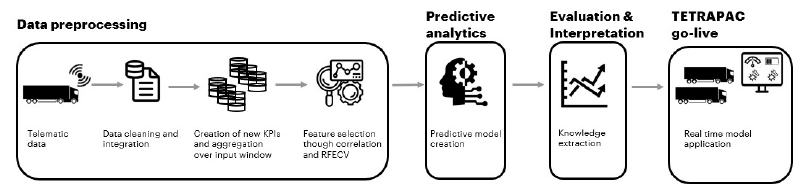
Figure 2. TETRAPAC building